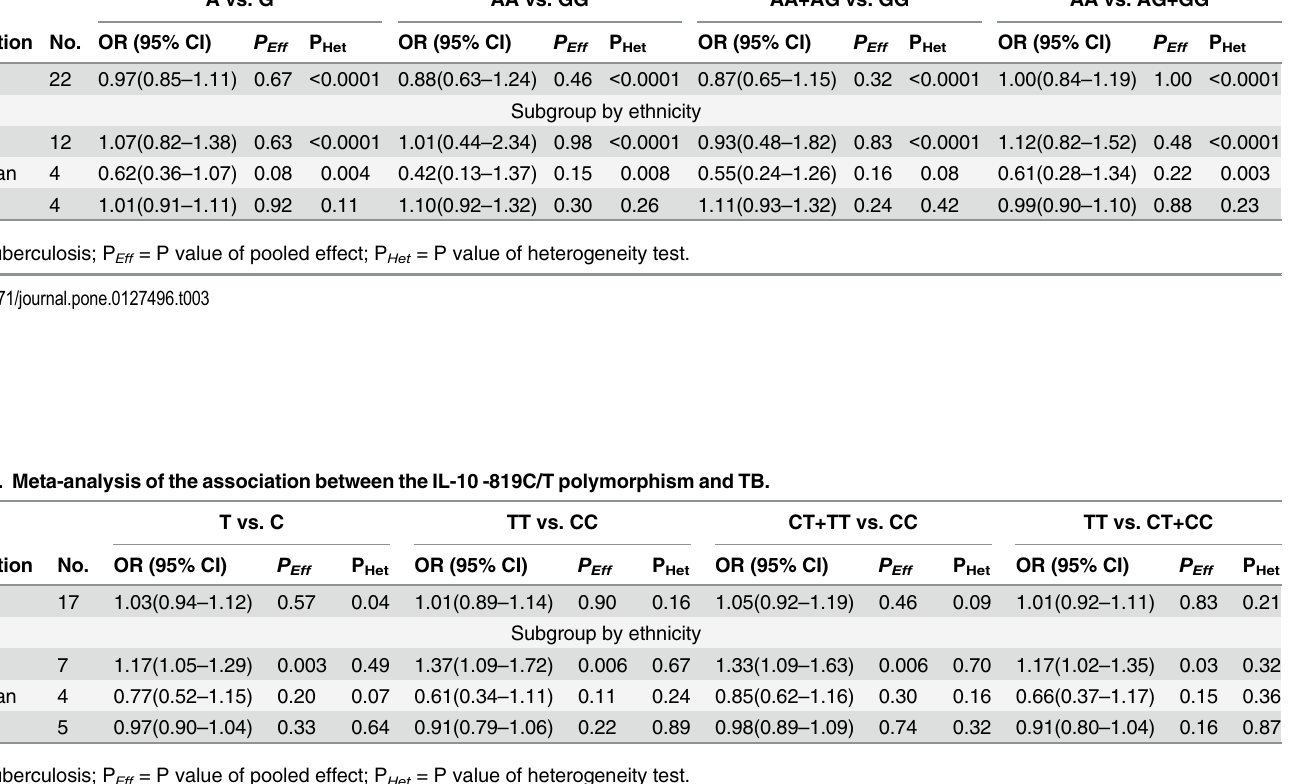
Table 3. Meta-analysis of the association between the IL-10 – 1082 G/A polymorphism and TB. A vs. G AA vs. GG AA vs. AG+GG